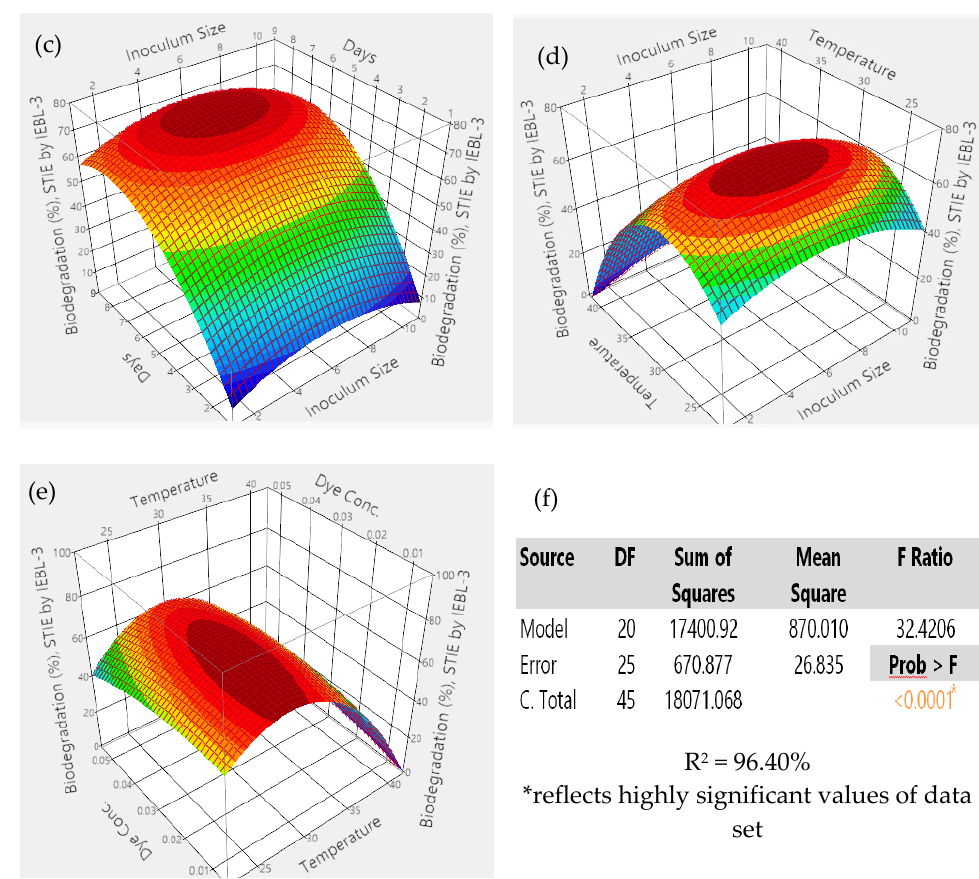
Figure 3. The 3D response surface graphs of interaction between parameters during the bio- degradation of ST industrial effluent by P. betulinus IEBL-3; there is positive interaction between ( a )—pH and size of inoculum ( b )—pH and temp. ( c )—size of inoculum and time ( d )—size of inoculum and temp. ( e )—temp. and dye conc. ( f )—statistical analysis.